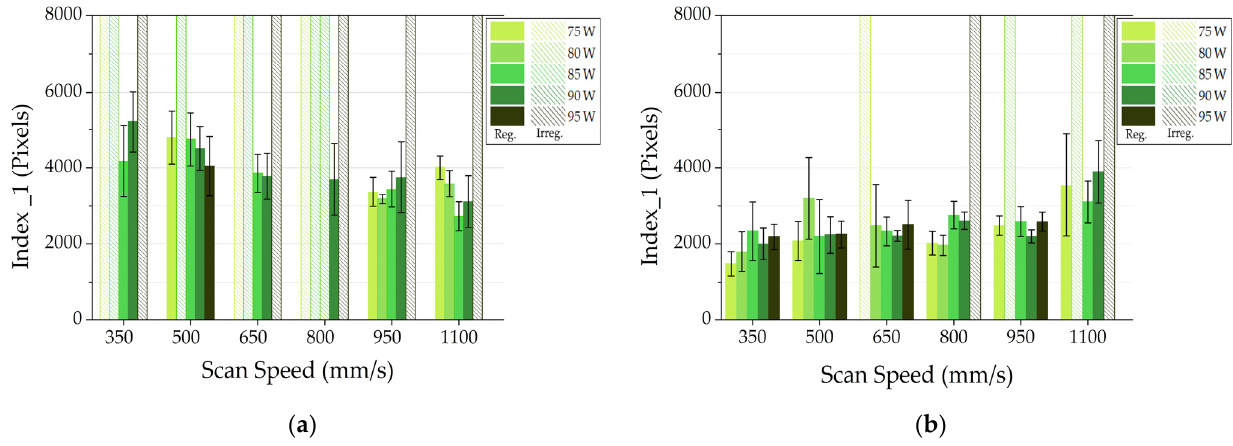
Figure 6. Index 1 for AlSi10Mg SSTs built with a layer thickness of 20 μ m ( a ) or 25 μ m ( b ).